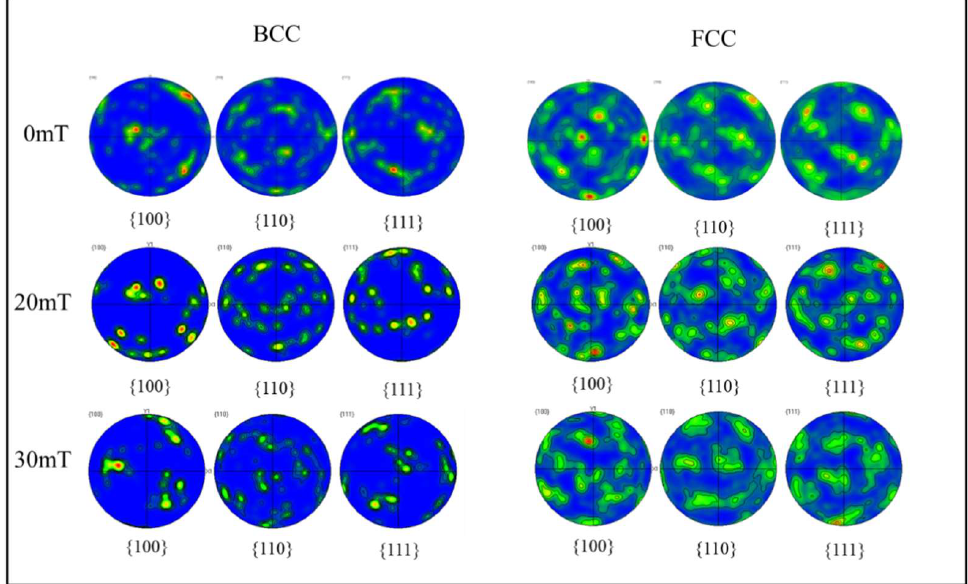
Figure 8. Pole figures of ferrite and austenite of weld under different alternating magnetic field intensities.